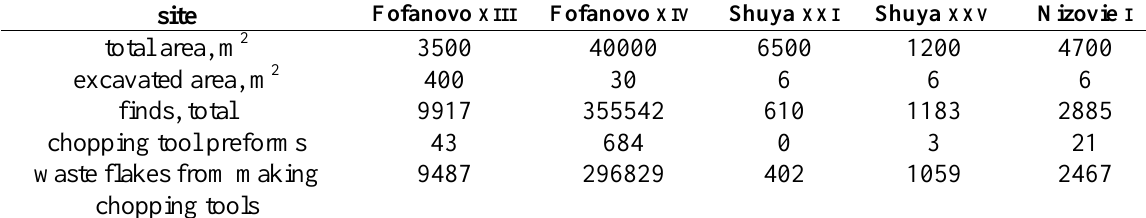
Table 2. Number of finds from excavated workshop sites in the outfall of Shuya